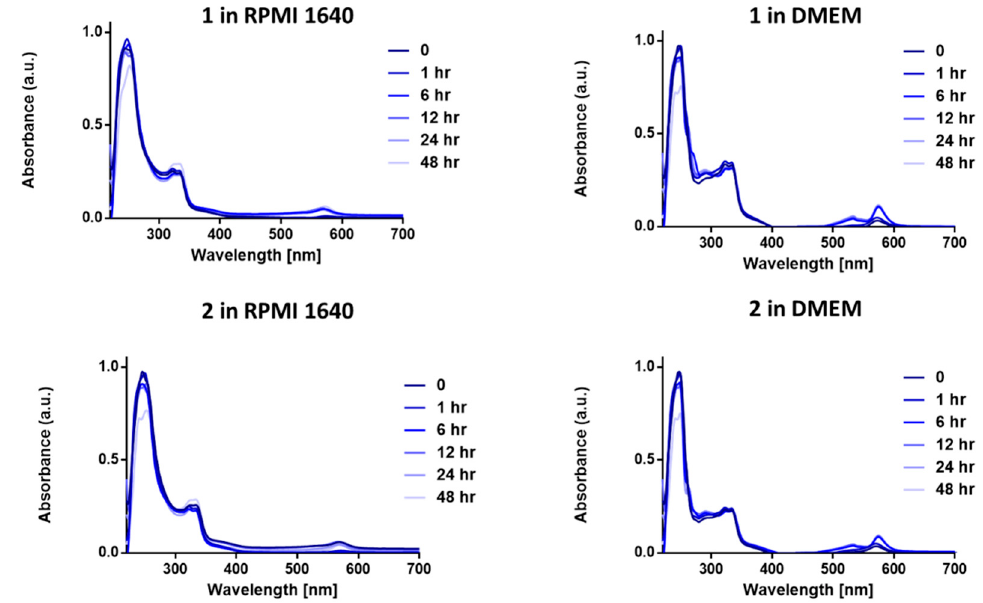
Figure 3. UV − vis spectra of 1 and 2 (50 µM) in Dulbecco’s modified eagle medium (DMEM) and Roswell Park Memorial Institute-1640 (RPMI-1640) over a period of 48 h showing the stability of compounds 1 and 2 at 37 °C.